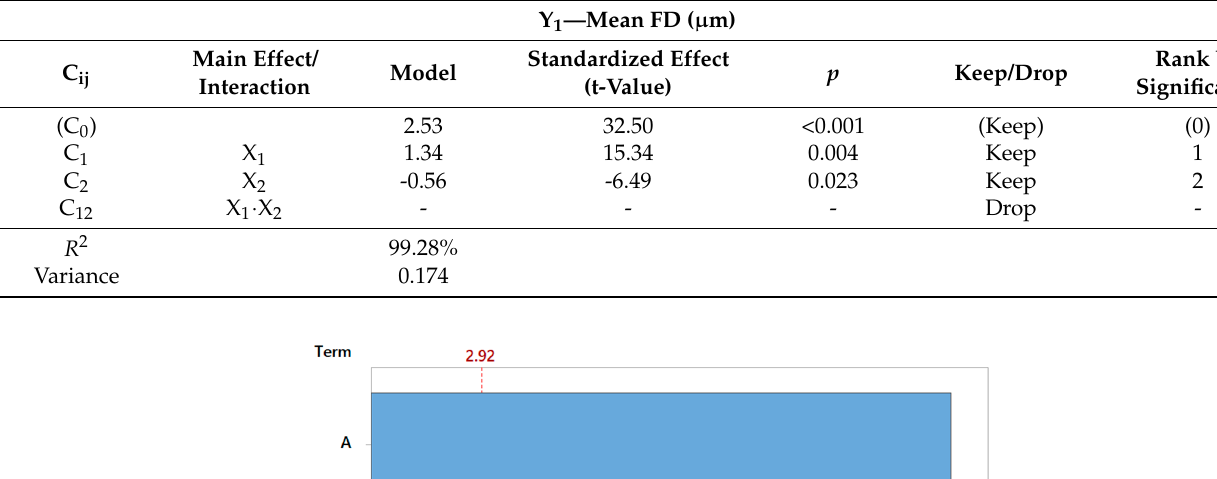
Table 6. Model in coded units for output variable Y 1 obtained by dropping terms with p-value > 0.1.